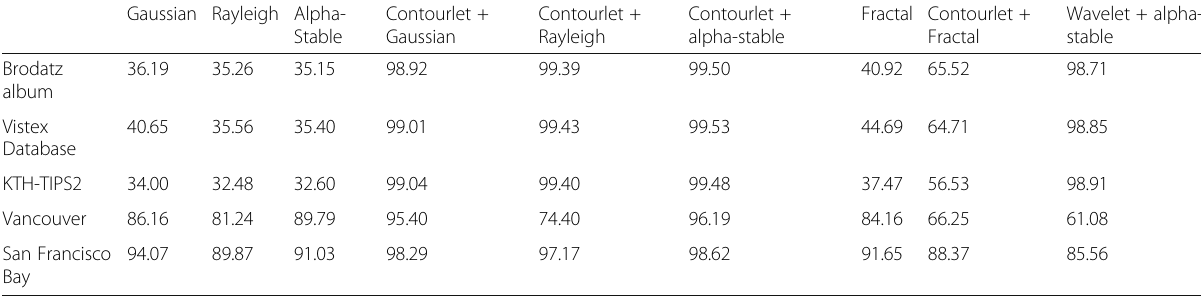
Table 2 Average segmentation accuracy of different methods (without noise) Gaussian Rayleigh Alpha-